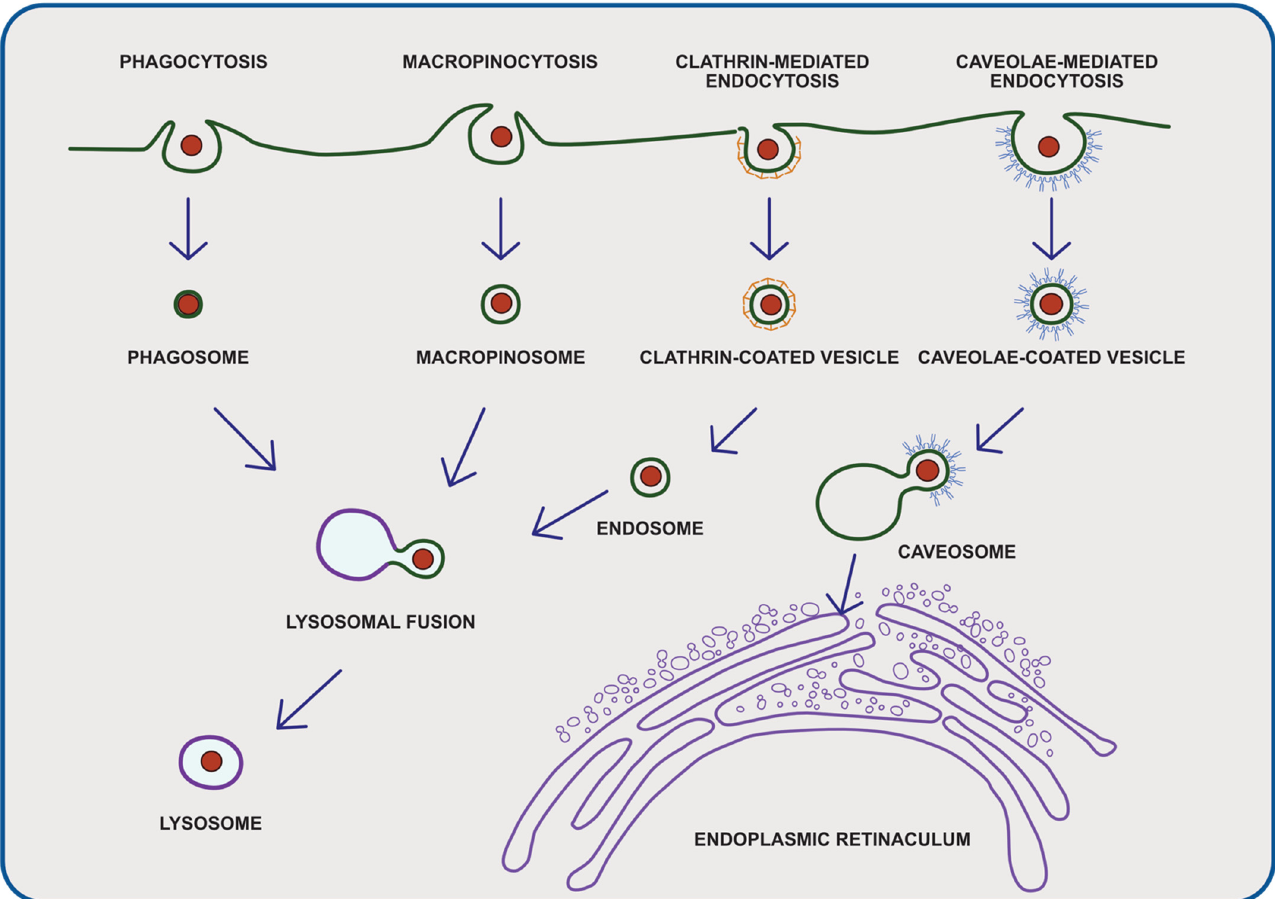
Figure 1. Four routes of cellular uptake of plastic particles: (1) phagocytosis, (2) micropinocytosis, (3) clathrin-mediated endocytosis, (4) caveolae-mediated endocytosis. After entering the human body, micro- and nanoplastics can interact with various cells; the number of absorbed particles depend on several factors, including the size, surface, charge, and chemistry of the encountered cells to which micro- and nanoplastics are